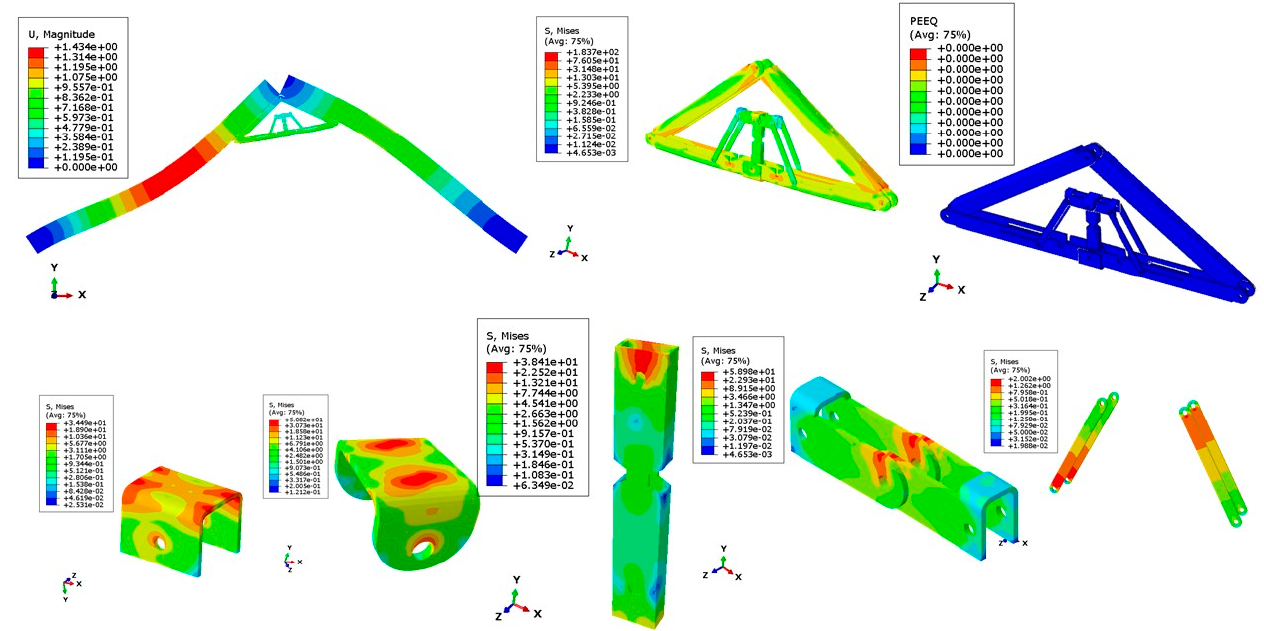
Figure 31. Stress (MPa) in wind load case (100% load removed from one side for hourly wind pressure of 0.85 kPa).